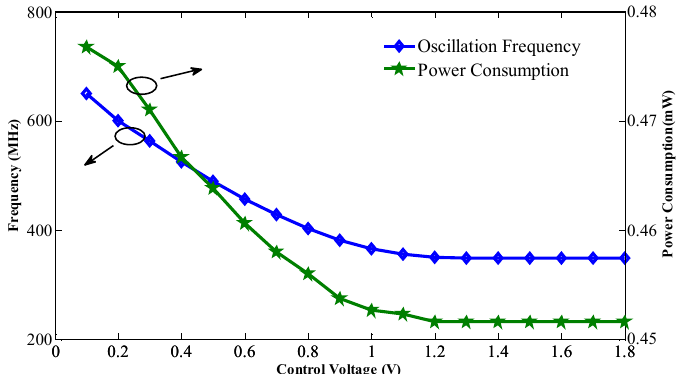
Figure 9. Measured tuning range and power consumption against control voltage.